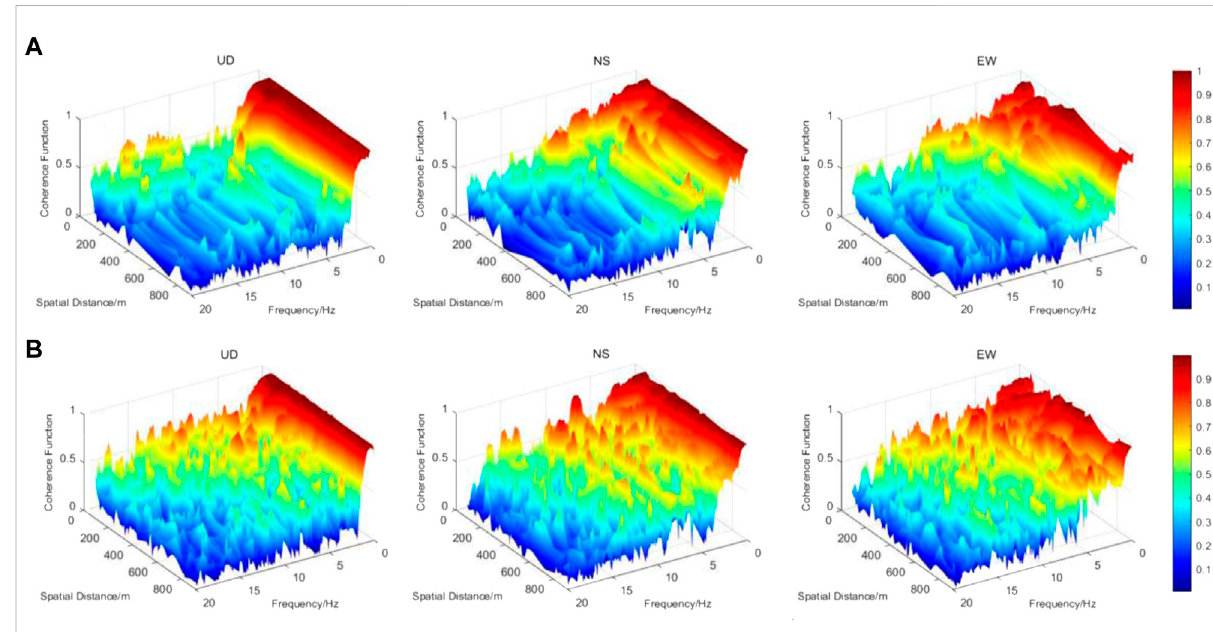
FIGURE 7 Lagged coherency 3D stereogram: (A) stereogram of the Luxian earthquake and (B) stereogram of the Yibin